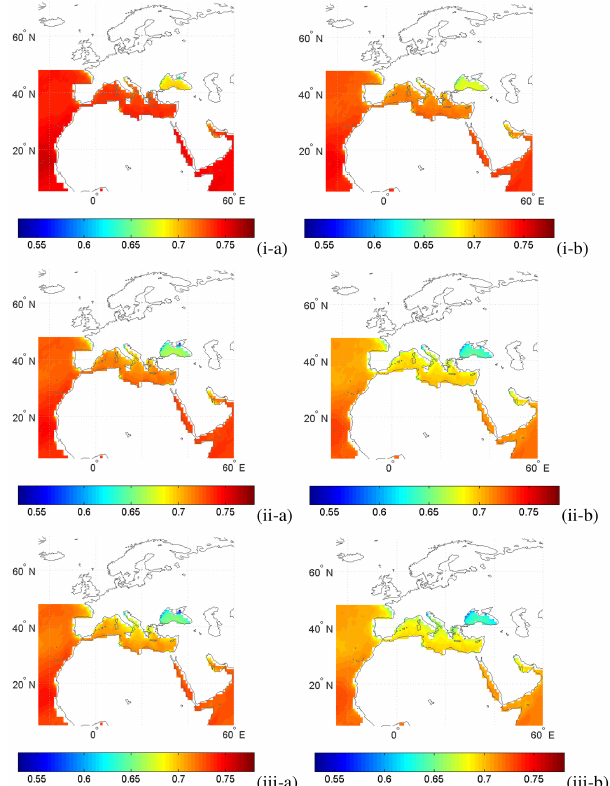
Figure 2. Geographical distribution of MODIS-Terra ( -a , left col- umn) and MODIS-Aqua ( -b , right column) g aer values averaged over 2002–2010, at the wavelengths of 470nm ( i- , top row), 660nm ( ii- , middle row) and 860nm ( iii- , bottom